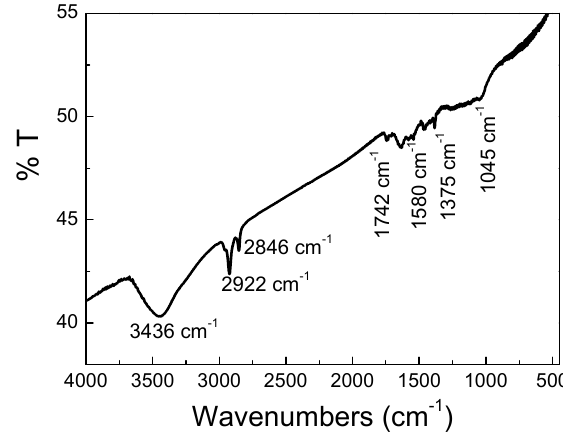
Figure 5. The FTIR spectrum of the biochar.